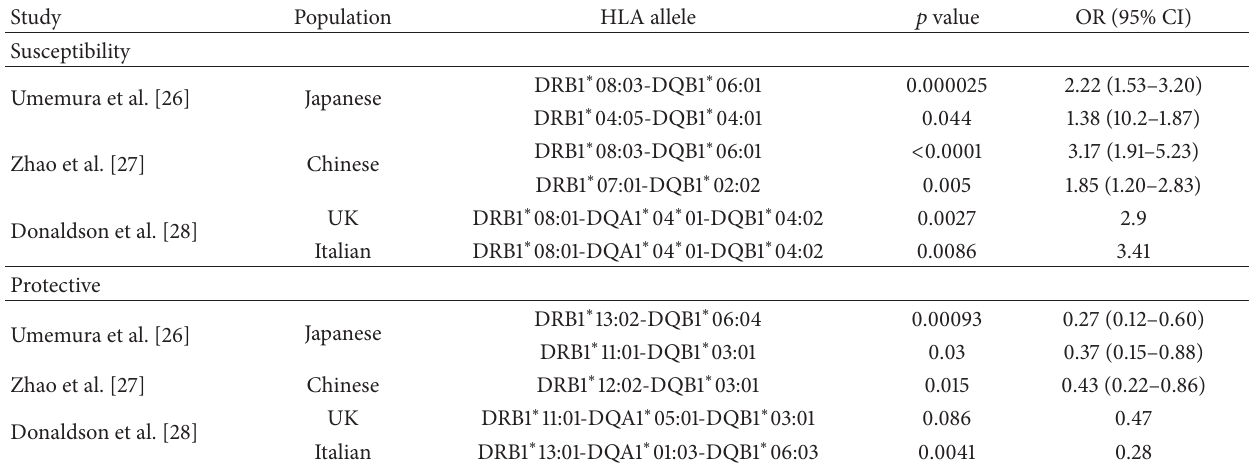
Table 1: HLA haplotype associations with